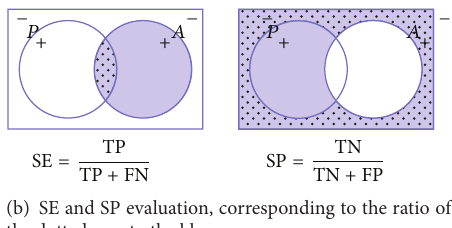
(b) SE and SP evaluation, corresponding to the ratio of the dotted area to the blue area Figure 6: Evaluation metrics: (a) confusion matrix and (b)